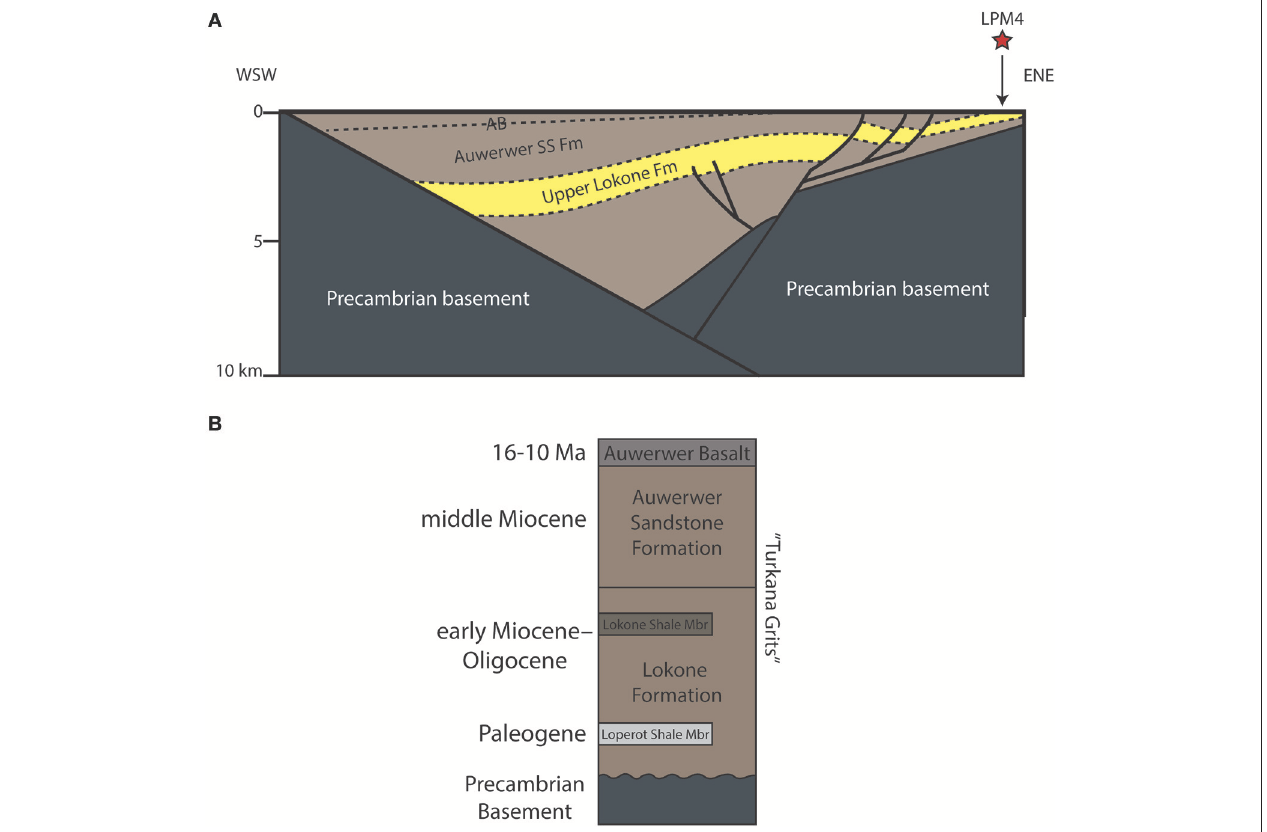
FIGURE 2 | Geology and stratigraphy of the Lokichar Basin. (A) Cross-section of subsurface geology of the Lokichar Basin, interpreted from seismic data presented in Morley et al. (1999b). The upper Lokone Formation is highlighted, and due to the half-graben geometry of the basin, it reaches the surface to the east nearest the Lokone uplift. (B) Generalized stratigraphy of the Lokichar Basin, modified from Morley et al. (1999b).